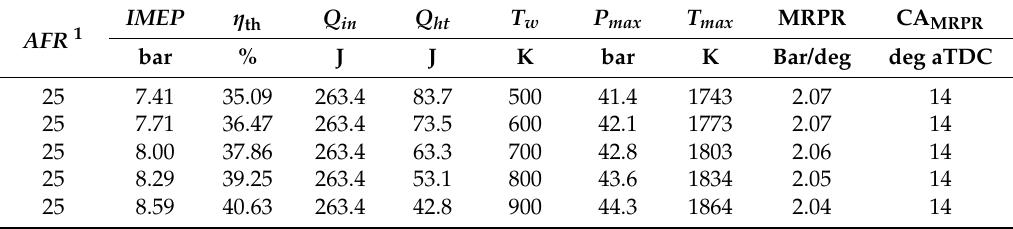
Table A3. Effects of wall temperature on the simulated results for combustion pattern